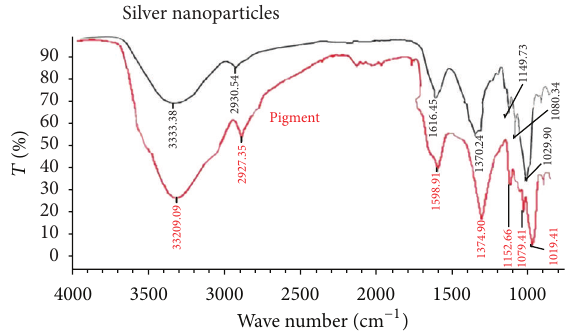
Figure 5: FTIR spectra of synthesized silver nanoparticles and